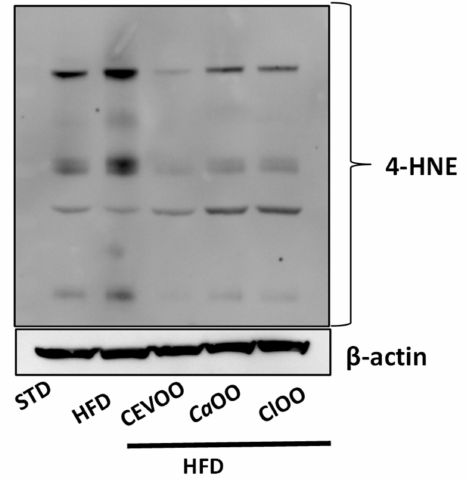
Figure 10. E ff ects of CEVOO, Ca OO and Cl OO diet supplementation on 4-HNE protein adducts in aortic tissues from HFD fed rats. The 4-HNE antibody recognizes the total of 4-HNE protein adducts. Representative western blot analysis of 4-HNE protein adducts. Each line contains 50 µ g of total proteins obtained from aortic vessels of rats treated as designated. β -actin is reported as loading control. Endothelial